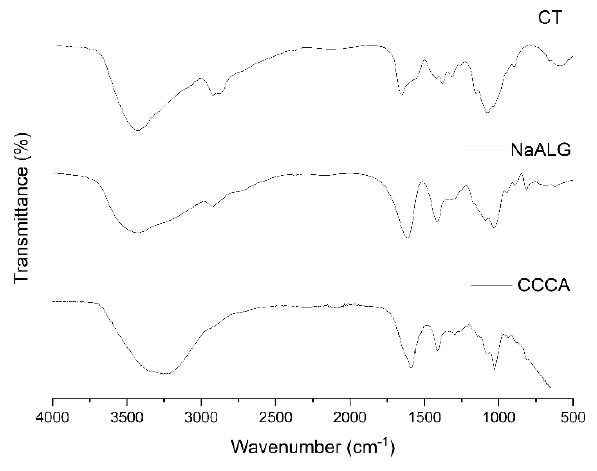
Figure 7. ATR-FTIR of CT, NaALG and